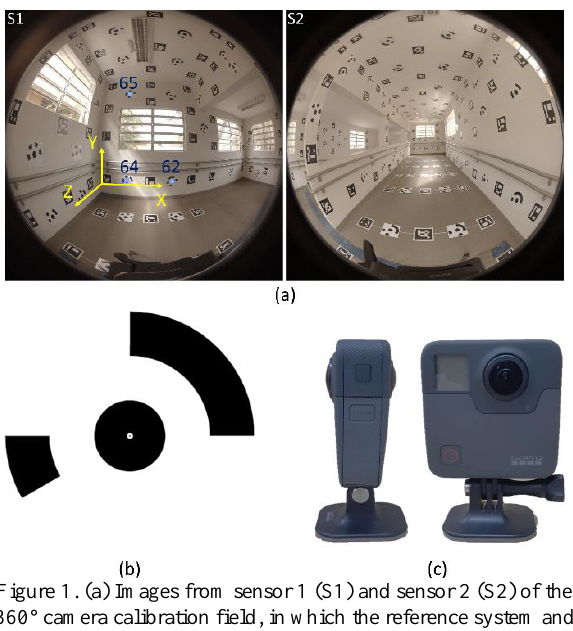
Figure 1. (a) Images from sensor 1 (S1) and sensor 2 (S2) of the 360° camera calibration field, in which the reference system and the 3 CTs used in the self-calibration are illustrated in S1, (b) Agisoft Metashape/Photoscan coded targets (CTs) and (c) a lateral and frontal view of the GoPro Fusion camera.